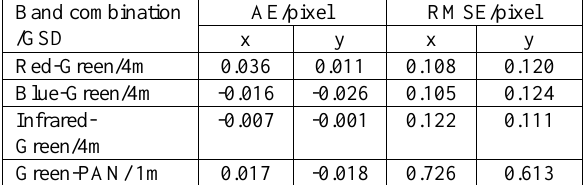
Figure 3. The ROI multispectral image before and after band-to- band registration Table 1. The registration evaluation results of corrected